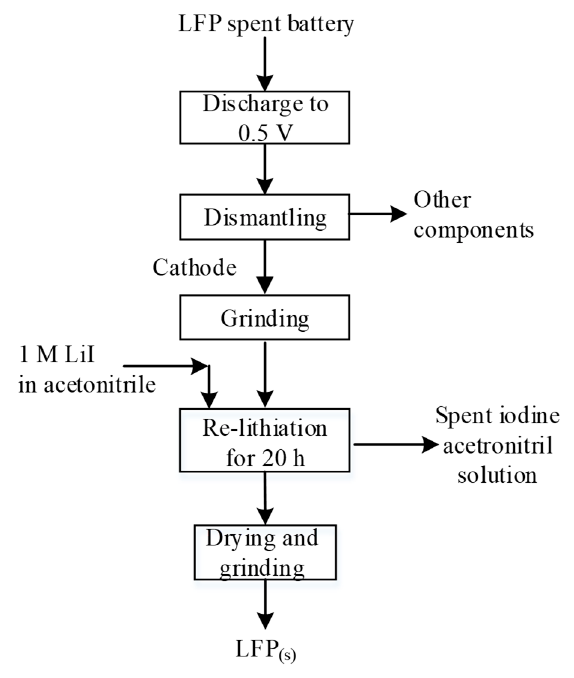
Figure 19. Iodide relithiation process proposed by Ganter et al. (according to [217]).